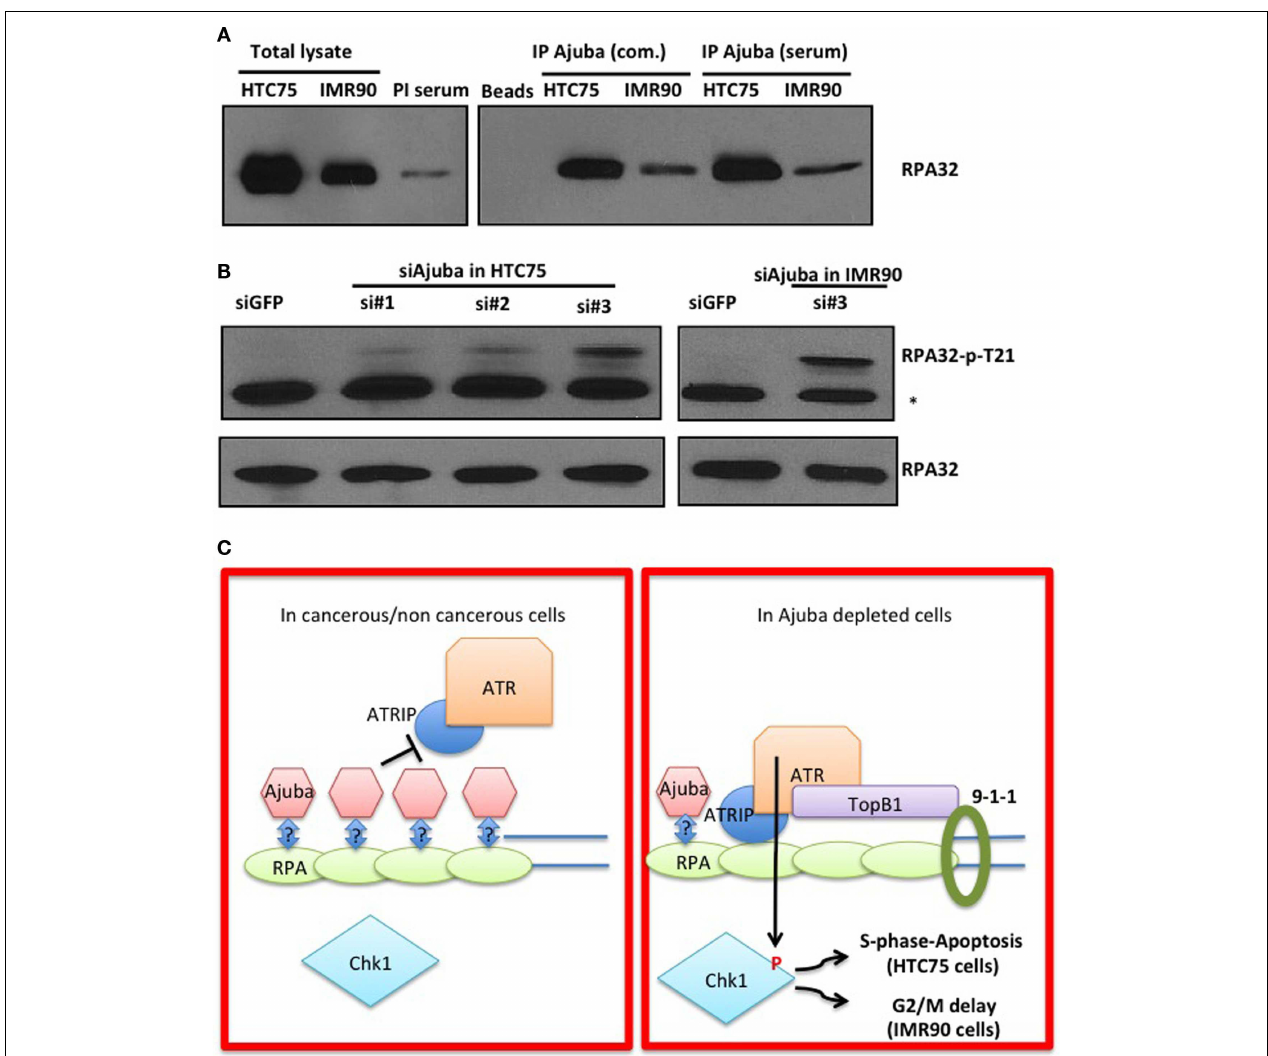
immunoprecipitation. (B) Western for RPA32-p-Thr21 in both HTC75 and IMR90Ajuba-depleted cells. A non-specific band is marked by a *.Total RPA32 levels are shown at the bottom. (C) Model for the role of Ajuba in repression of ATR.The “?” indicates that the interaction between Ajuba and RPA could be direct or indirect. See text for